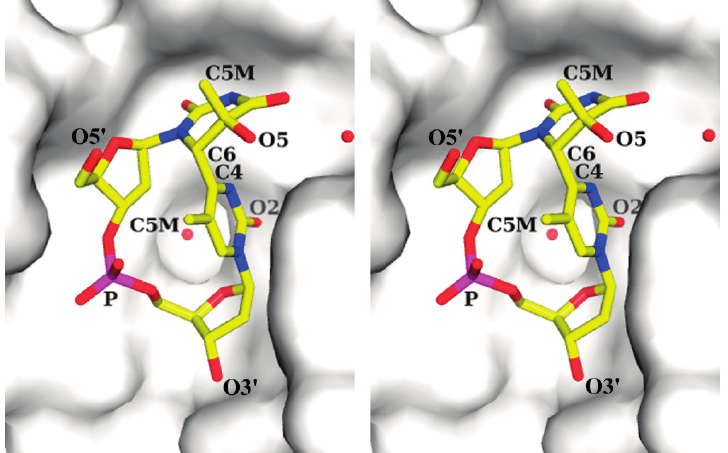
Figure 2. Stereo drawing of the structure of dT(6-4)T in the crystal structure of the 64M-2 Fab—dT(6-4)T complex (PDB ID: 1EHL). The dT(6-4)T molecule is shown as a stick model (C atoms, yellow; N atoms, blue; O atoms, red; P atoms, magenta), and several atoms were numbered. The Fab is represented as a grey surface model. Water molecules are drawn with red spheres. All molecular figures in this study were produced with PyMOL